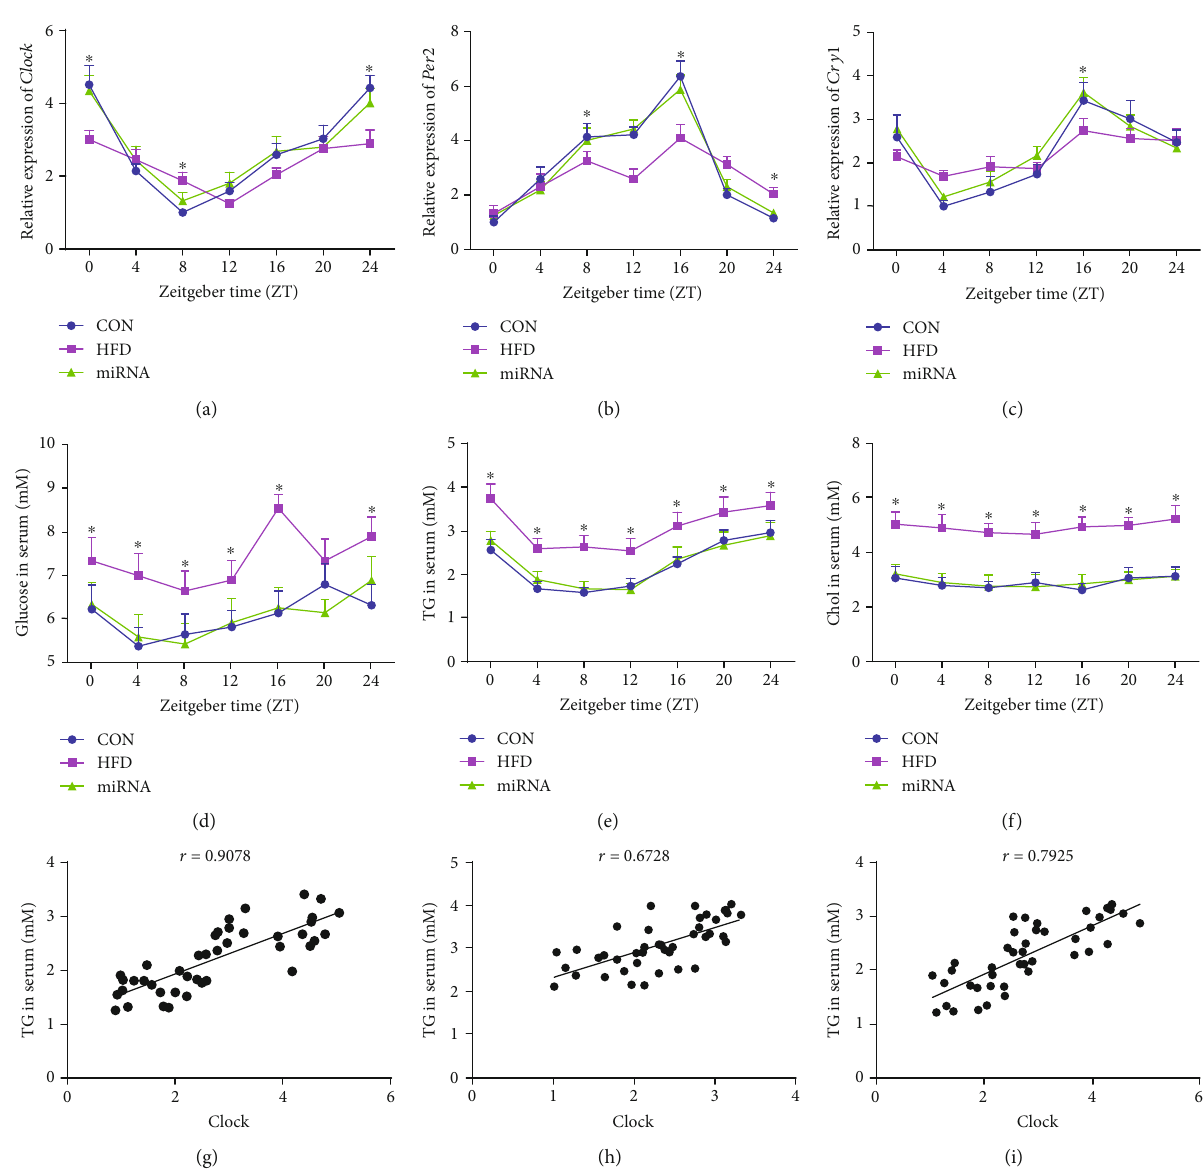
Figure 2: E ff ects of miRNA-10a-5p on diurnal rhythms of the hepatic clock gene and serum lipids in high-fat diet-fed mice. (a) Relative expression of Clock ; (b) relative expression of Per2 ; (c) relative expression of Cyr1 ; (d) glucose content in serum; (e) triglyceride content in serum; (f) cholesterol content in serum; correlation between triglyceride content and Clock expression in CON group (g), HFD group (h), and miRNA group (i). Data were expressed as Mean ± SEM . ∗ P < 0 : 05